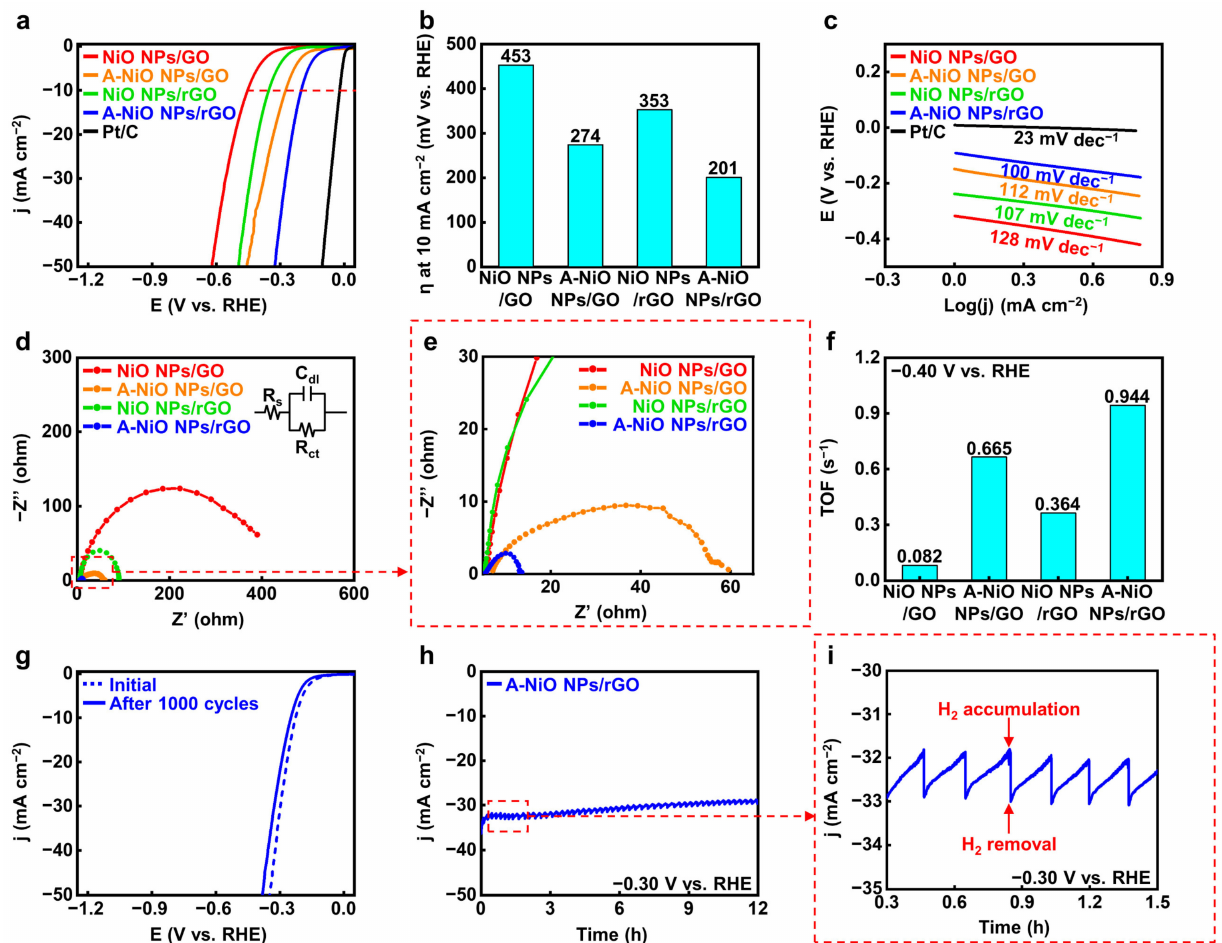
Figure 4. Electrochemical measurement for HER. ( a ) LSV curves for HER and ( b ) corresponding overpotentials at 10 mA cm − 2 of NiO NPs/GO, A-NiO NPs/GO, NiO NPs/rGO, A-NiO NPs/rGO, and Pt/C in 1 M KOH at a scan rate of 5 mV s − 1 . ( c ) Tafel slopes of NiO NPs/GO, A-NiO NPs/GO, NiO NPs/rGO, A-NiO NPs/rGO, and Pt/C. ( d ) EIS curves and ( e ) enlarged data of NiO NPs/GO, A-NiO NPs/GO, NiO NPs/rGO, and A-NiO NPs/rGO at an overpotential of − 0.30 V vs RHE. Inset of ( d ) is the Randles circuit of the HER. ( f ) Histograms for TOF of NiO NPs/GO, A-NiO NPs/GO, NiO NPs/rGO, and A-NiO NPs/rGO at − 0.40 V vs. RHE. ( g ) LSV curves of A-NiO NPs/rGO before and after 1000 cycles of durability test. ( h ) CA test of A-NiO NPs/rGO under an overpotential of − 0.30 V vs. RHE for 12 h. ( i ) Zoomed in data from ( h